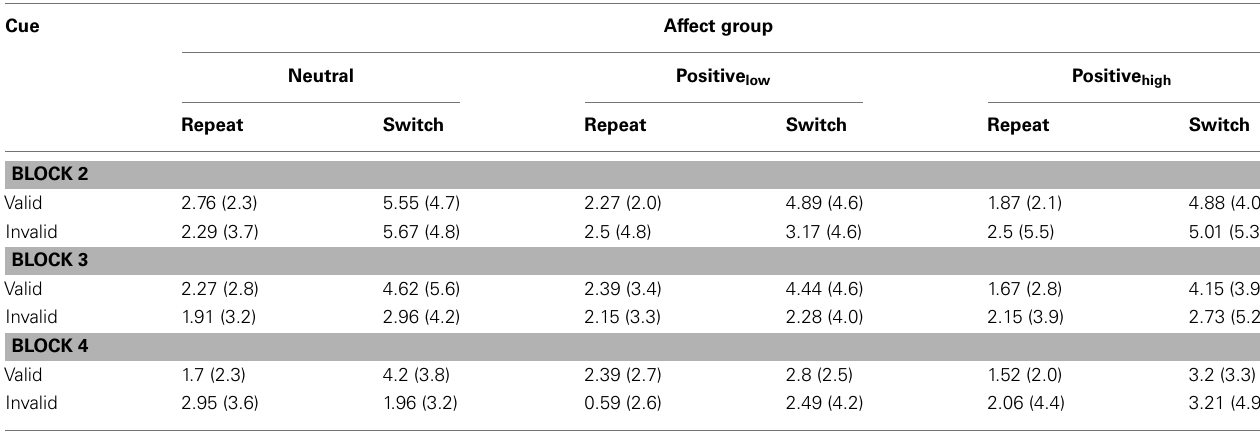
Table 5 | Mean error rates (in %, SD in parentheses) in experimental blocks 2–4 of experiment 3 (task switching with informative task cues) as a function ofAffect group,Trial type, and Cue